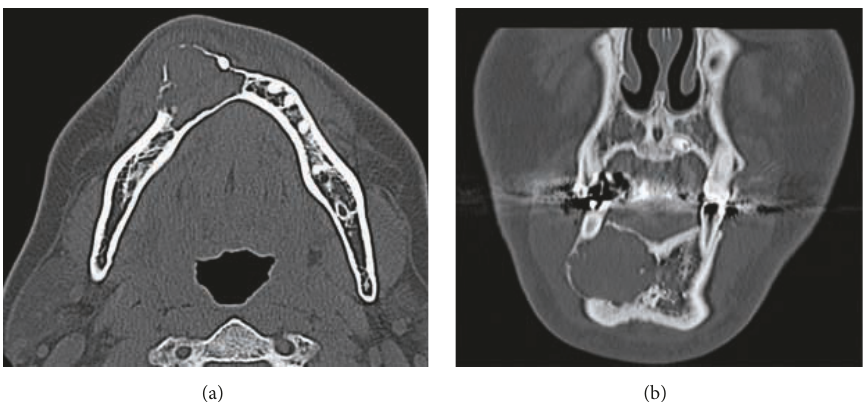
Figure 3: (a) Axial and (b) coronal computed tomography scans showing a large unilocular radiolucent lesion in the right mandible.